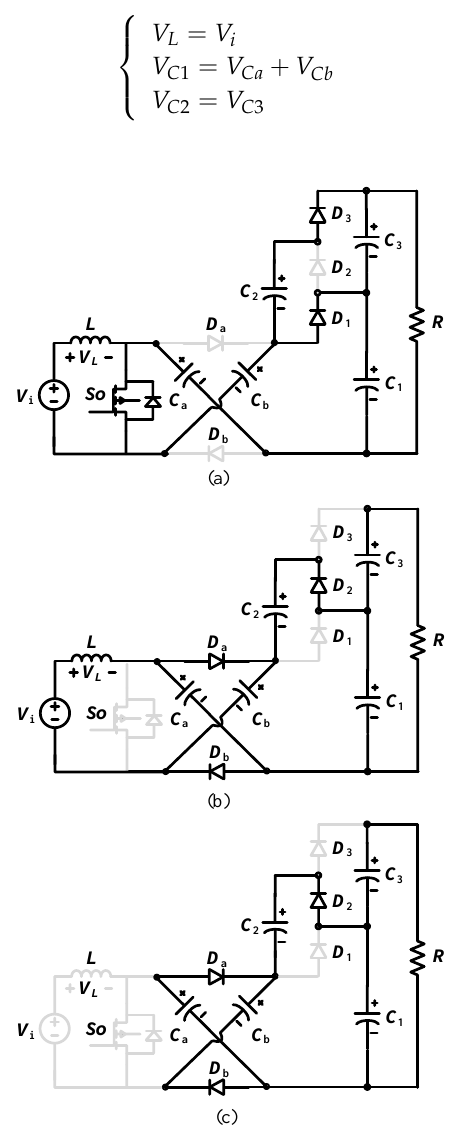
Figure 5. The operating mode of the proposed converter: ( a ) S 0 on, ( b ) S 0 off, and ( c ) the circuit in DCM.